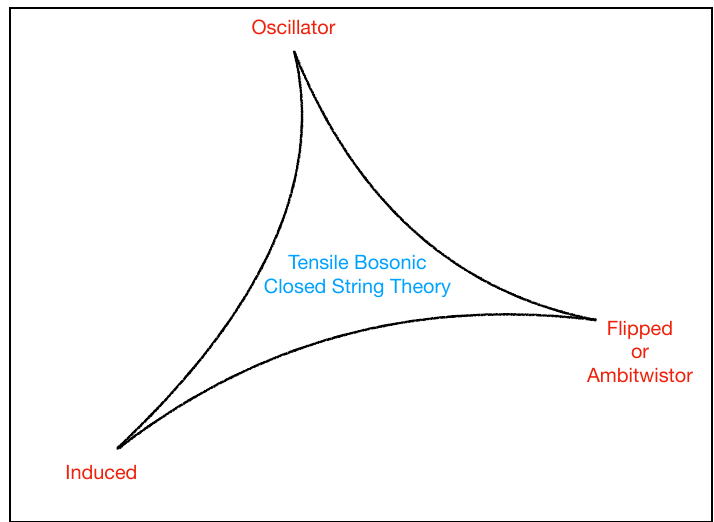
Figure 1 . Tensionless corners of Bosonic String